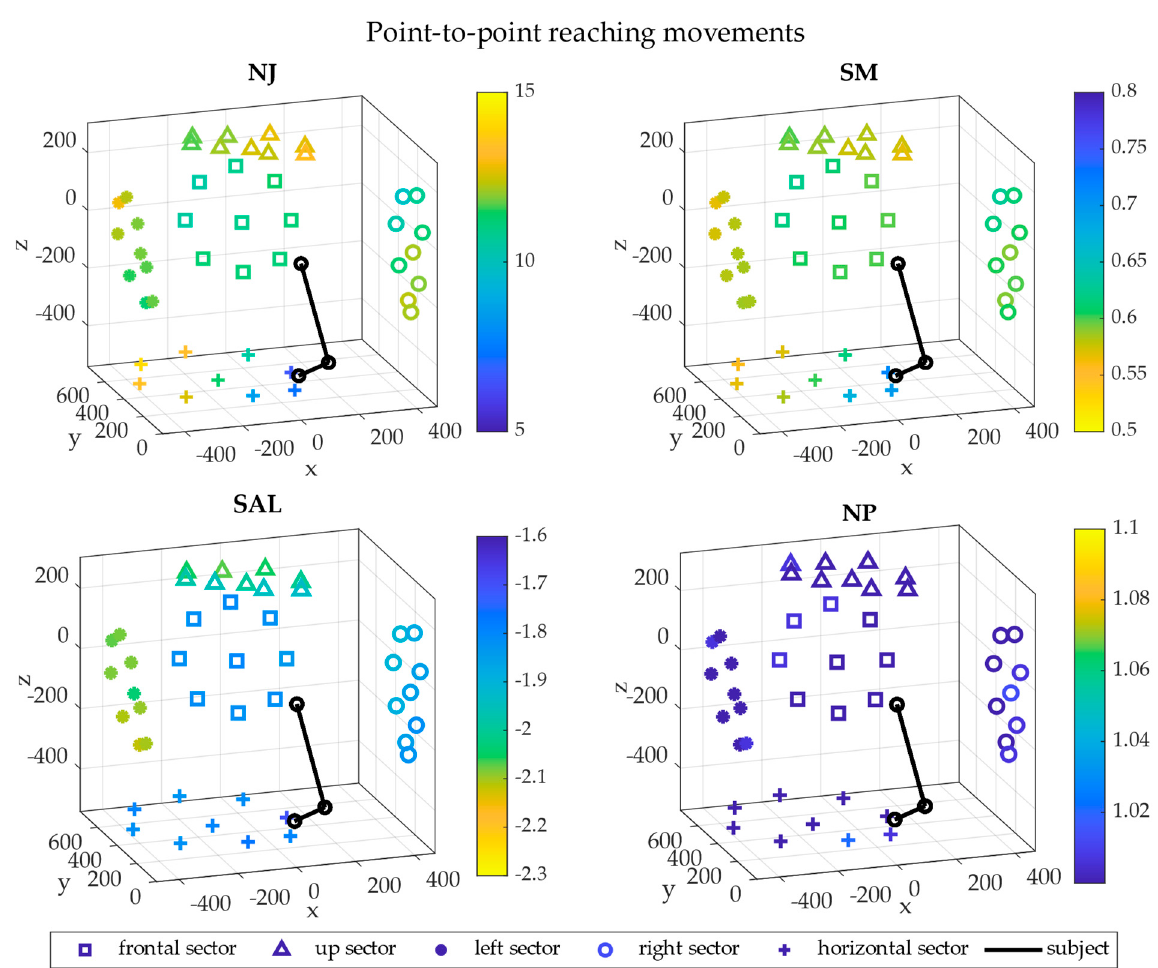
Figure 6. 3D maps in cartesian coordinates—P2P movements. The 3D maps representing the level of smoothness are reported in cartesian coordinates referred to the shoulder. The five sectors are visualized in the 3D space with different shapes: frontal (square), up (triangle), left (bullet), right (circle) and horizontal (cross). The upper limb starting position is represented in black for a typical subject for visual reference. Each point is the average across repetitions and subjects and their colors indicate the magnitude of the metrics. The x axis points to the right of the subject, the y axis points frontally and the z axis is vertical.